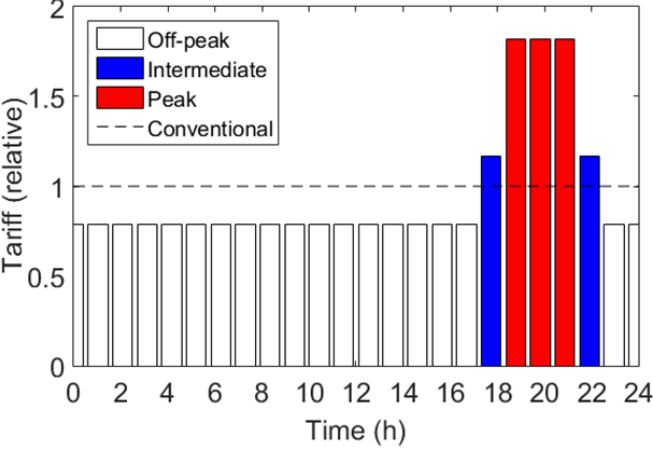
Figure 4. Time of use tariff.